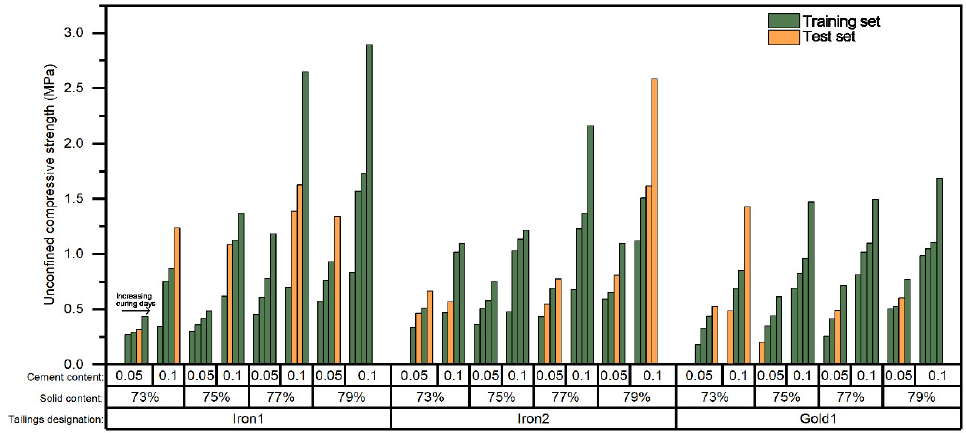
Figure 7. The specific data distribution of the training set and test set based on the overall randomly segmented dataset.